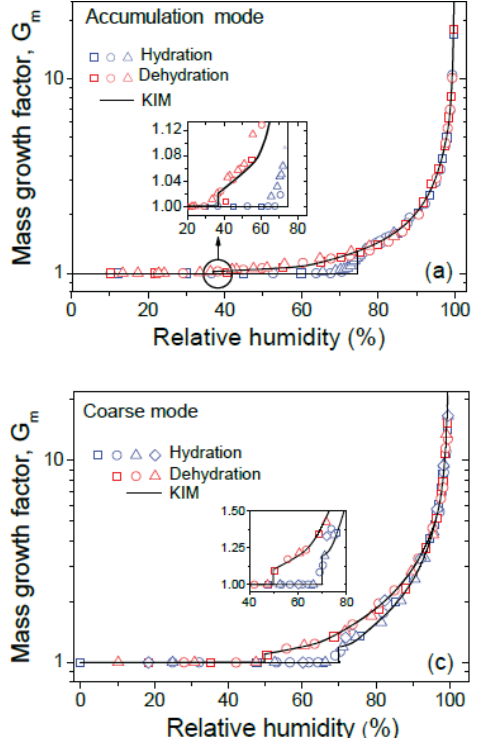
Figure 3. Mass growth factors of particles collected at the ZOTTO site in Serbia in June 2013: (upper panel) accumulation mode; (lower panel) coarse mode. The solid curves represent simulations using the κ m -interaction model (KIM). Reprinted with permission by Mikhailov et al.